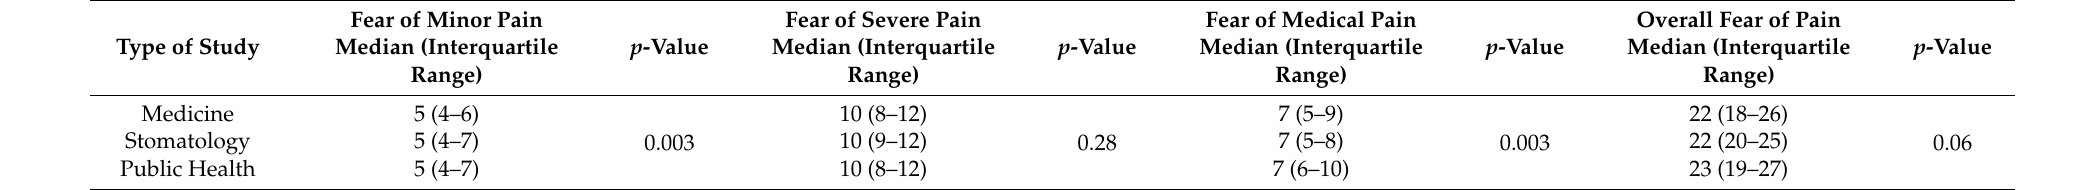
Table 6. Fear of pain between